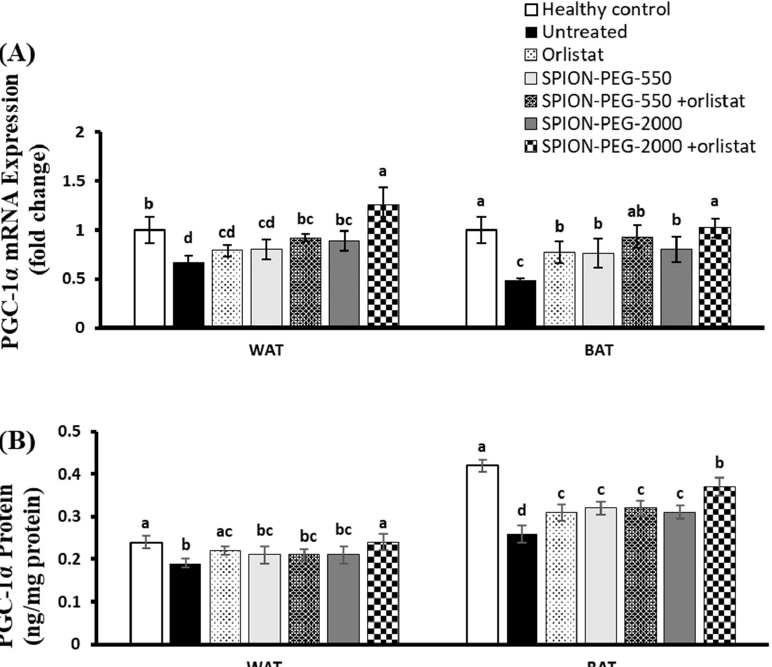
Figure 6. PGC-1 α expression in white and brown adipose tissues at mRNA ( A ) and protein ( B ) levels in control rats and obese rats untreated or treated with SPIONs and/or orlistat. Data presented as mean ± SD, and n = 8. Groups were compared at p < 0.05 using one-way ANOVA and Tukey post hoc test, and those which are not assigned with a shared letter (a–d) are statistically significant.